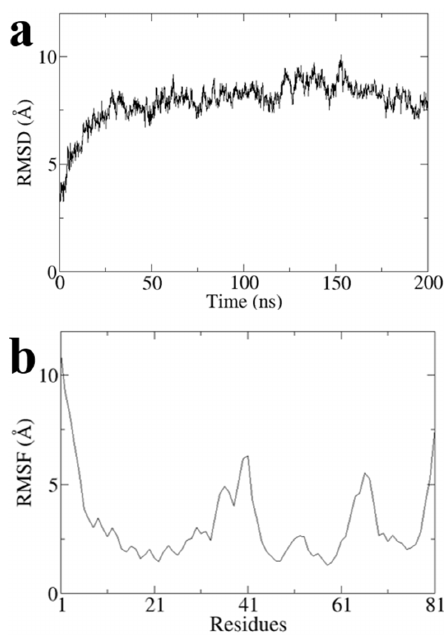
Figure A1. Analysis on the MD trajectory of Model 3. ( a ) The time evolution of RMSD and ( b ) RMSF of residues. Both RMSD and RMSF were calculated using all the C α atoms.